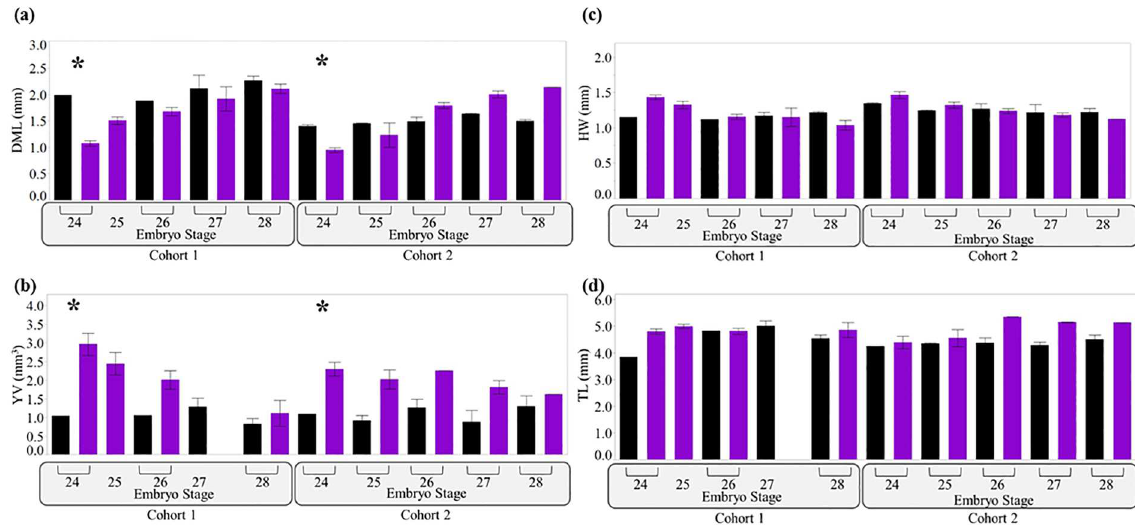
Fig 7. Experiment 1: Embryonic response to treatment when standardized by developmental stage. (a) DML = Dorsal mantle length(mm). (b) YV = Yolk volume (mm 3 ). (c) HW = Head width (mm). (d) TL = Total length (mm). X-axis: Embryos are groupedby cohort, embryo stage and treatment. Numbers 24–28 = Embryo stage. Treatment = low pHOx (purple/gray) or high pHOx (black). * = treatment effect ( p < 0 . 001 ).Bars = ± 1 standarderror.